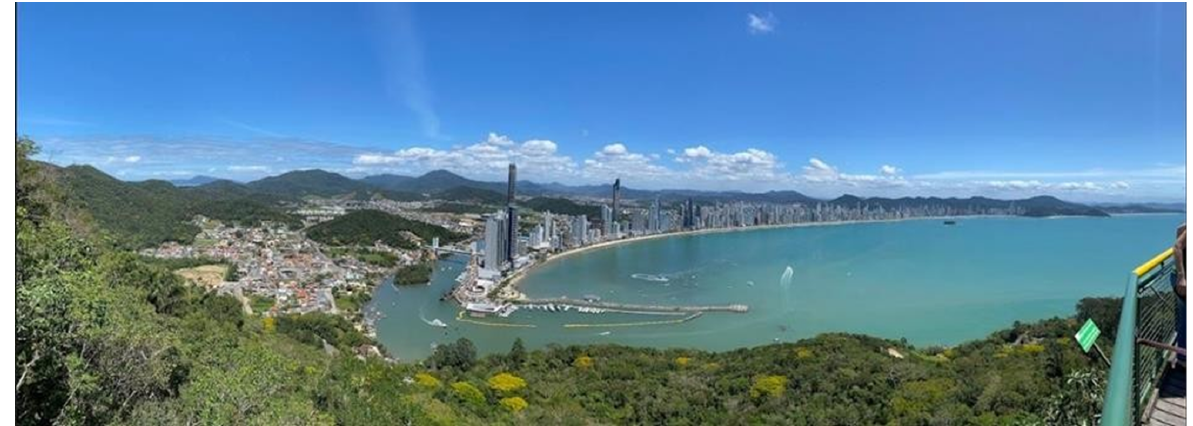
Figure 2. Panoramic view of Balneário Camboriú/SC, Brazil. Source: Authors, taken during fieldwork, December 2020.